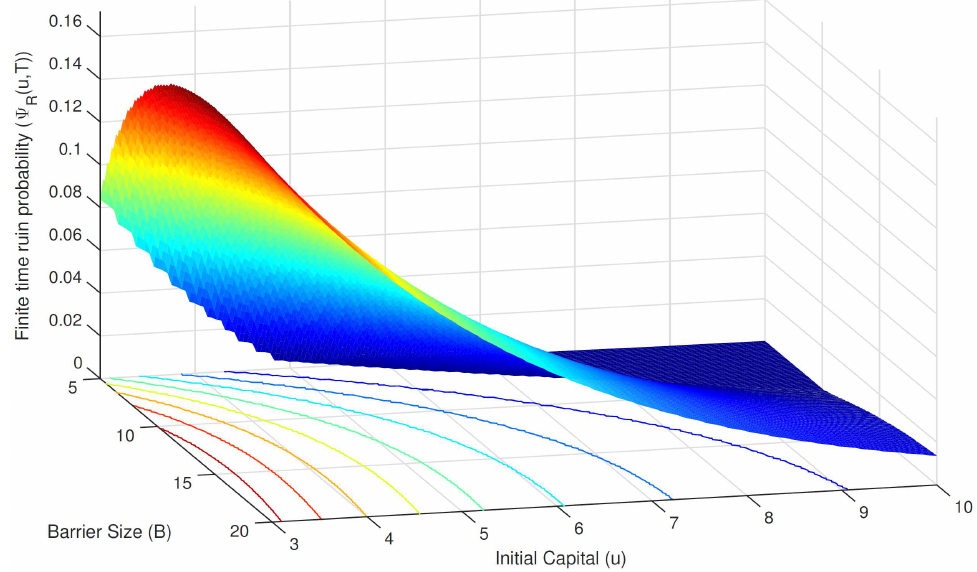
Figure 7. Plot of finite-time ruin probability with stop-loss reinsurance: this is a numerical approxi- mation showing how initial capital and stop-loss retention level influence finite-time ruin probability. Initial capital varies from 3 to 10, the retention level from 5 to 20, h = 0.005, τ = 0.01, K = 12, and all other parameters are as in Table